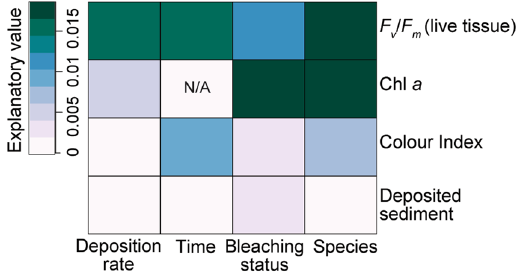
Figure 5. Explanatory value of each of the fixed factors included in the models, including deposition rate treatment (mg cm − 2 ), Time (d), Species and bleaching status (normally pigmented or bleached), with darker colours indicating increased importance of that variable. Explanatory value was calculated simply as the additional R 2 obtained when a variable was included in a complete interaction model, compared to a model excluding just that variable. This in effect represents the unique variance explained by each predictor, rather than the overall R 2 explained by individual best models, as presented in Table